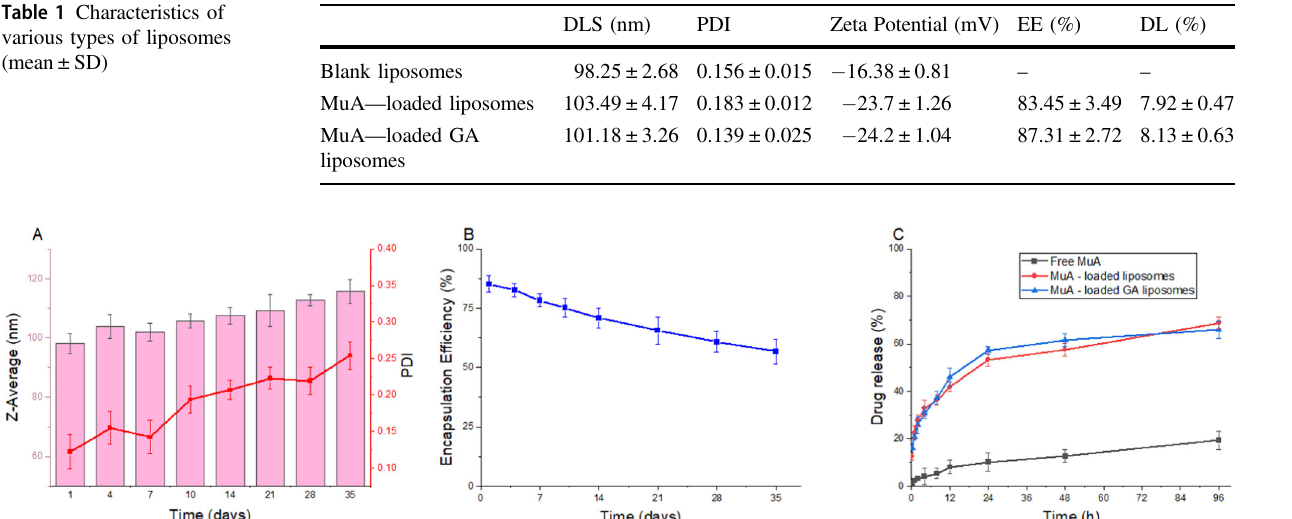
Fig. 3 Liposome stability and in vitro drug release of MuA — loaded GA liposomes. A The stability of liposome in real time storage, ( B ) The change of encapsulation ef fi ciency during 35 days, ( C ) The drug